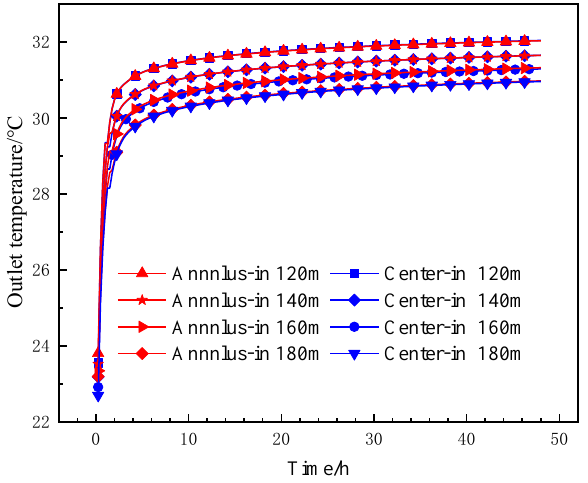
Figure 10. Outlet temperature with different depths.